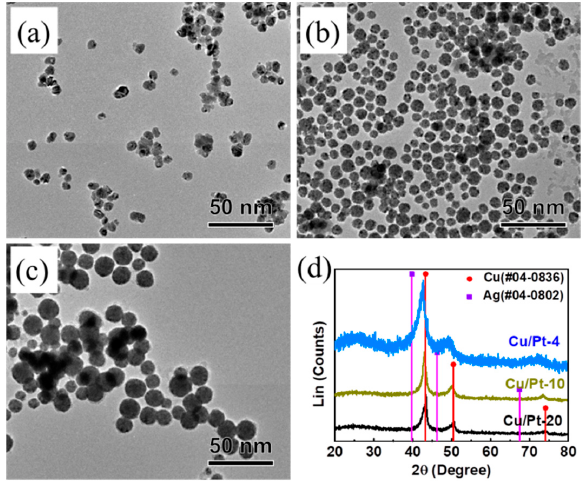
Figure 3. TEM images of as-prepared CuPt nanoparticles: ( a ) CuPt-20, ( b ) CuPt-10, ( c ) CuPt-4, and ( d ) the X-ray diffraction (XRD) pattern of CuPt nanoparticles.